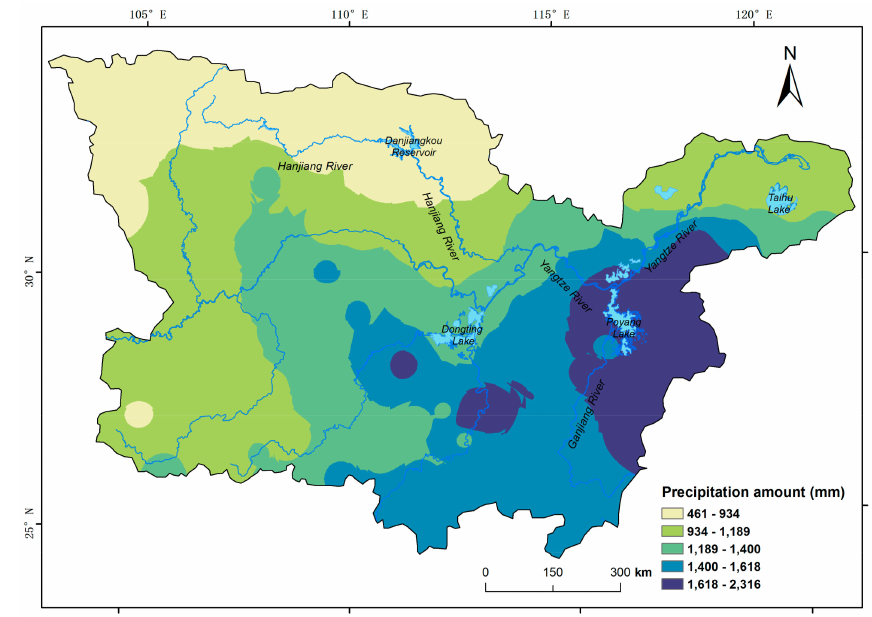
Figure 2. Average annual precipitation in the MLR-YR over the period